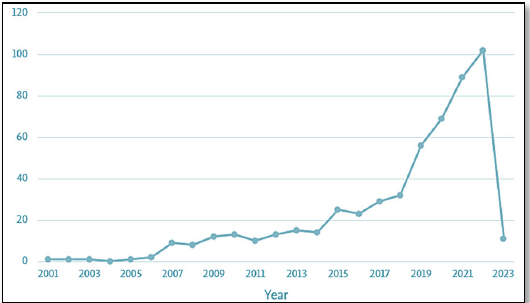
Fig. 2. Countries that published related to the words “Hydrogen”, “fuel” and “production”. Source: Scopus scientific